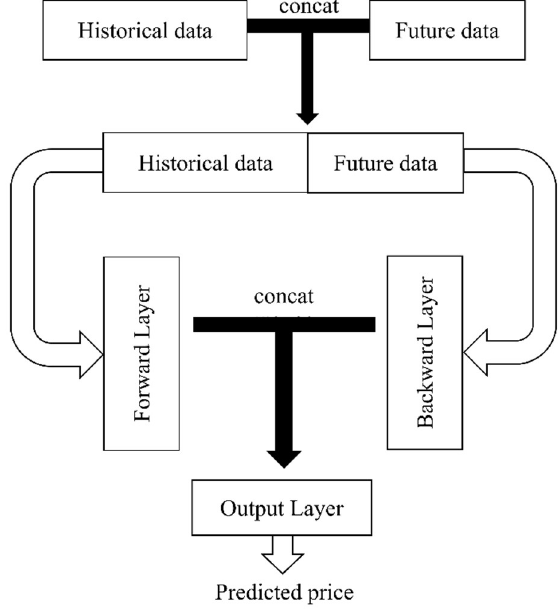
Figure 2. The model architecture of BRIM.